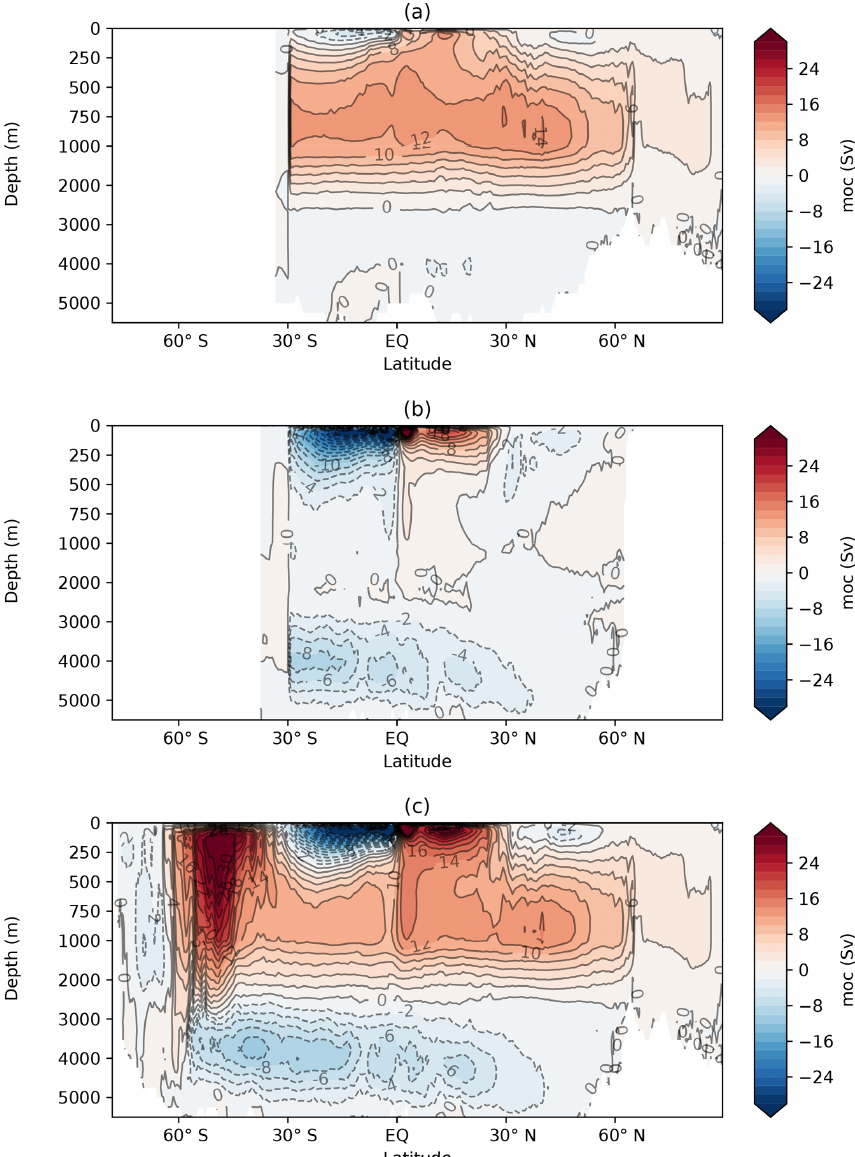
Figure 17. CanESM5 residual meridional overturning circulation in the Atlantic (a) , Indo-Pacific (b) , and global (c) oceans, averaged over 1981 to 2010, including all resolved and parameterized advective processes. Note that the depth scale on the y axis is